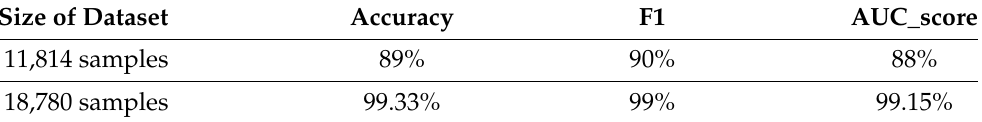
Table 4. Comparison between the results of datasets with 11,814 samples, and 18,780 samples.